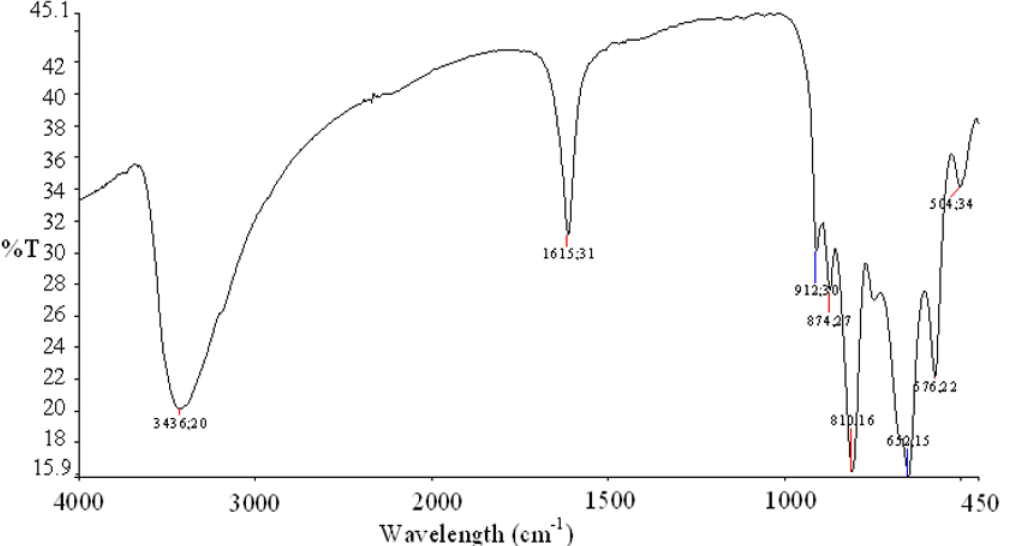
Figure 6. FT-IR spectrum of MnWO